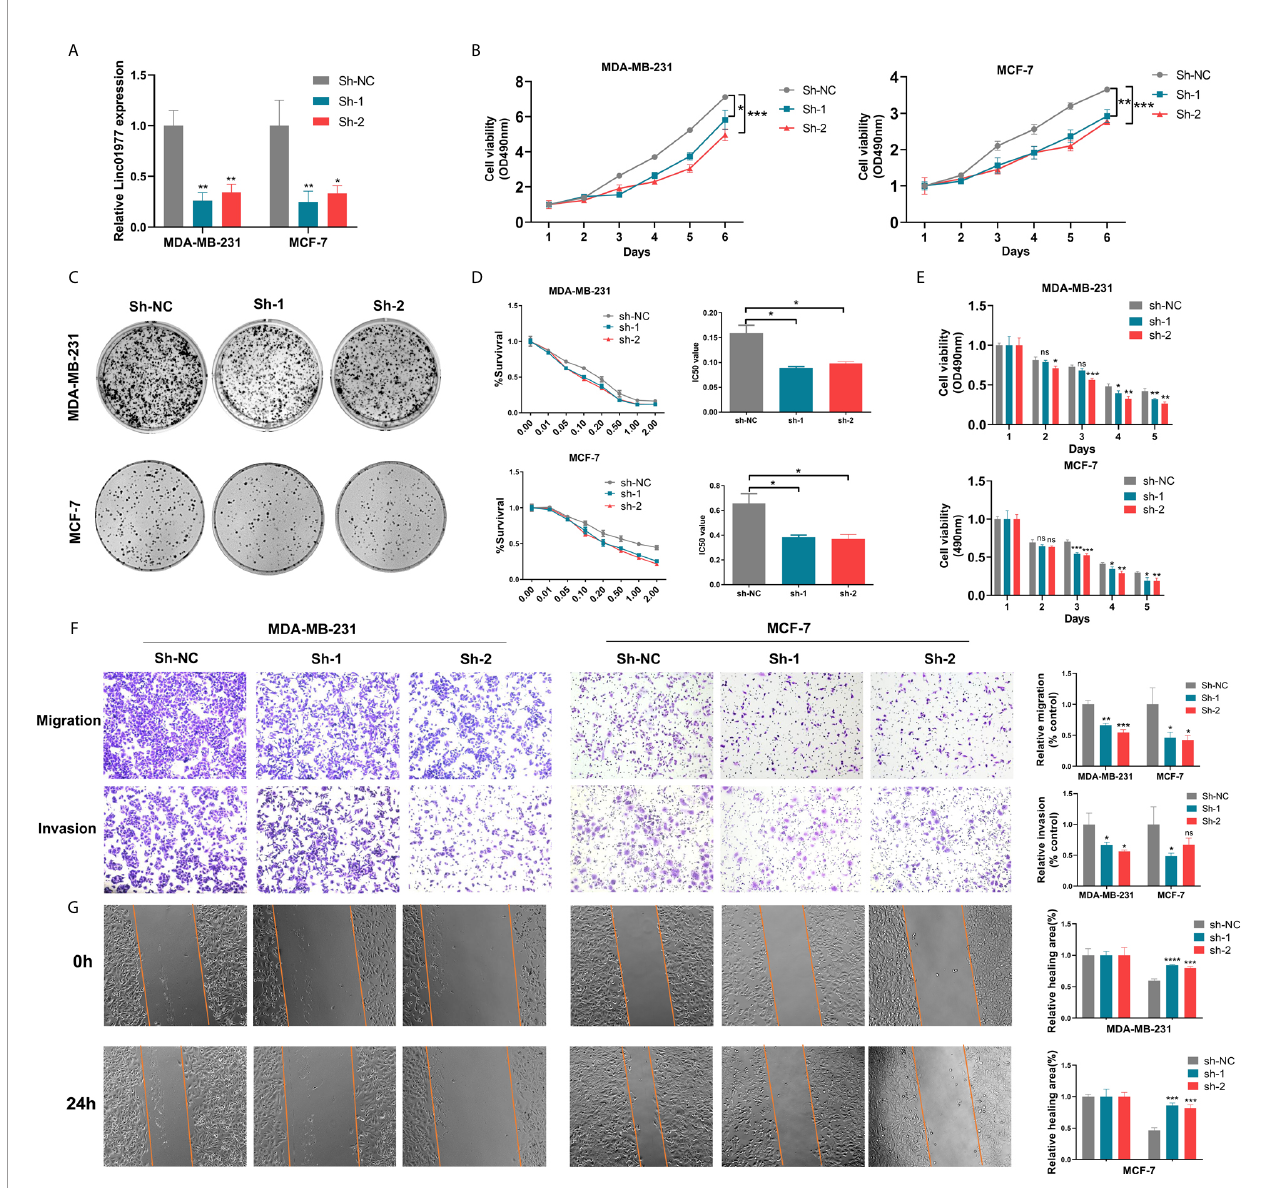
FIGURE 2 | LINC01977 knockdown reduced breast cancer cell proliferation, metastasis, and chemoresistance to DOX. (A) The ef fi ciency of shRNA knockdown was evaluated by real-time PCR in MDA-MB-231 and MCF-7 cells. (B) MTT assay was used to evaluate cell viability of MDA-MB-231 and MCF-7 transfected by control or knockdown plasmids. (C) Colony formation assay displayed the in fl uence of LINC01977 knockdown on breast cancer cell proliferation. (D) IC50 value for DOX in MDA-MB-231 and MCF-7 transfected by control or knockdown plasmids. (E) Cytotoxicity assay was used to test the suppression of DOX resistance caused by LINC01977 knockdown in MDA-MB-231 and MCF-7 cells. DOX concentration: 0.1 m M in MDA-MB-231 and 0.5 m M in MCF-7 cells. (F) Cell migration and invasion assays. (G) Wound healing assay. (*p < 0.05, **p < 0.01, ***p < 0.001, ****p < 0.0001; Student ’ s